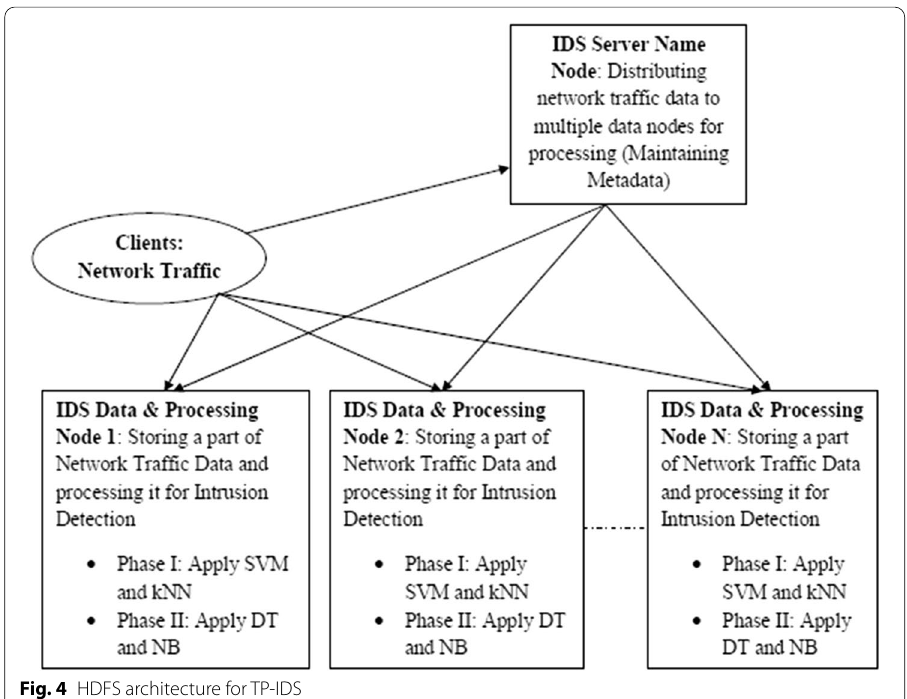
Fig. 4 HDFS architecture for